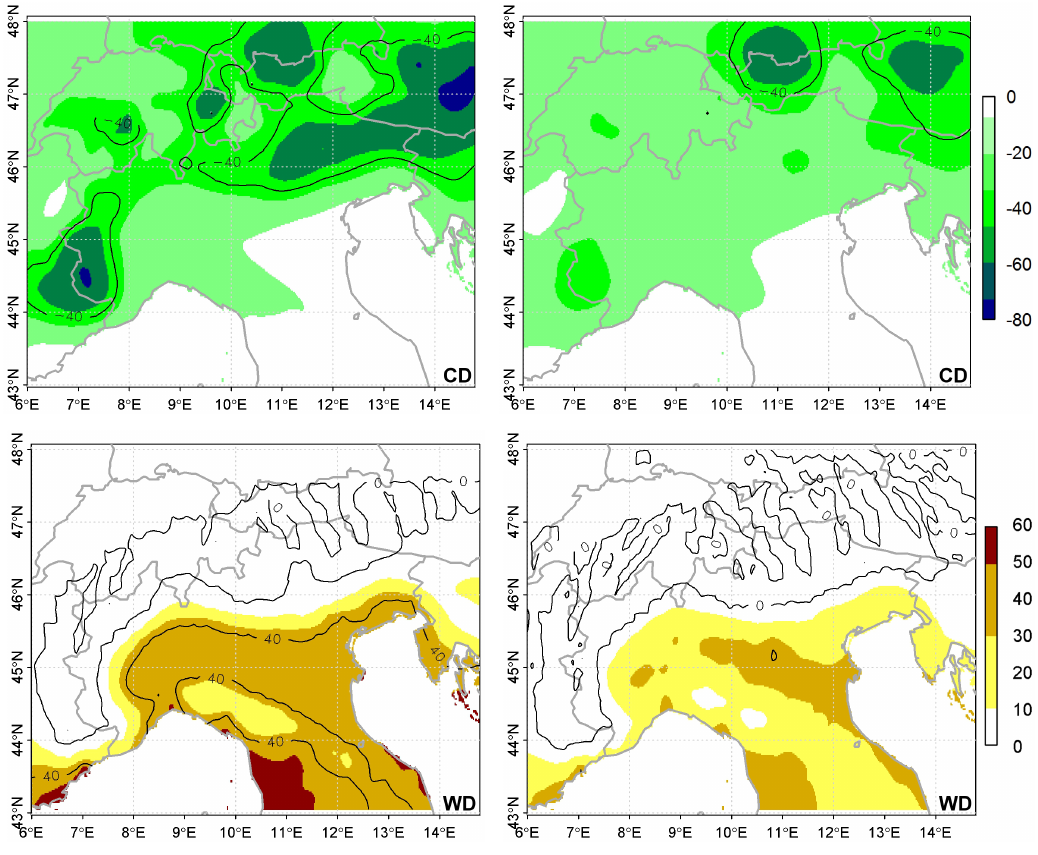
Figure 8. Number of days, expressed as anomalies between FC A 2 and the RC ( left panels ) and between FC B 2 and the RC ( right panels ), for cold days (CDs; T mean < 0 ◦ C) and warm days (WDs; T mean > 30 ◦ C). T mean is the daily mean temperature of the soil surface